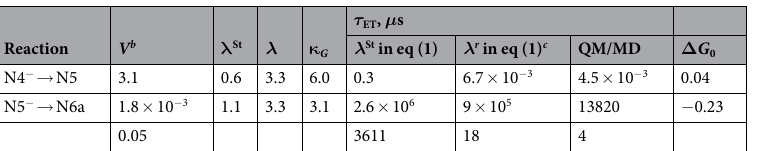
Table 1. Reorganization energies a and reaction free energies from simulations (eV) and calculated reaction time ( μ s). a The reorganization energies λ St and λ from QM/MD simulations. The reported variance reorganization energies λ = ( λ 1 + λ 2 )/2 are mean values between the forward ( λ 1 , 1 → 2) and backward ( λ 2 , 2 → 1) reactions calculated according to equation (4). λ 1 / λ 2 are equal to 2.1/4.6 eV for N4 − → N5 and 2.7/4.0 eV for N5 − → N6a. b Electron-transfer coupling (cm − 1 ) taken from ref. 22; for N5 − → N6a, the smaller value refers to the dry protein and the larger value refers to the protein with structural water included. c Determined from classical MD simulations in which X = − e Δ φ , Δ φ is the difference of electrostatic potentials at the centers of the acceptor and the